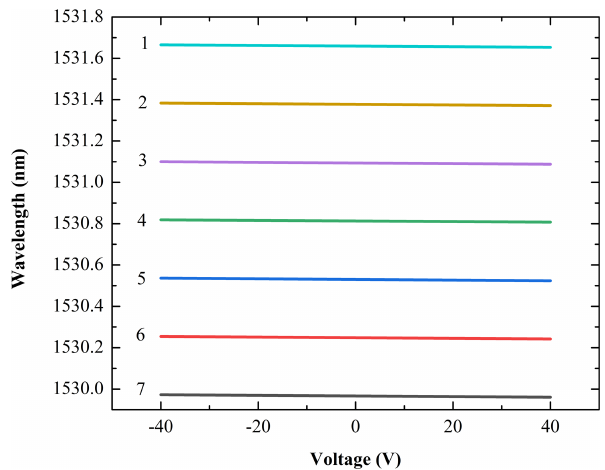
Figure 1. Tunable wavelength range of the WGM-diode laser for seven different wavelength bands when the laser temperature was fixed and the internal piezoelectric crystal was changed by an exter- nal